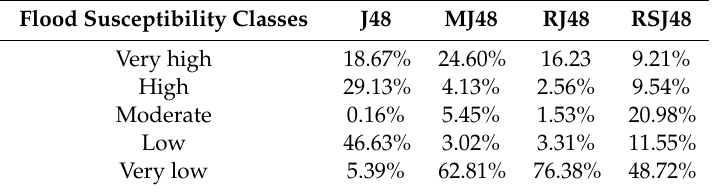
Table 3. Percentage of area under susceptibility classes in di ff erent machine learning